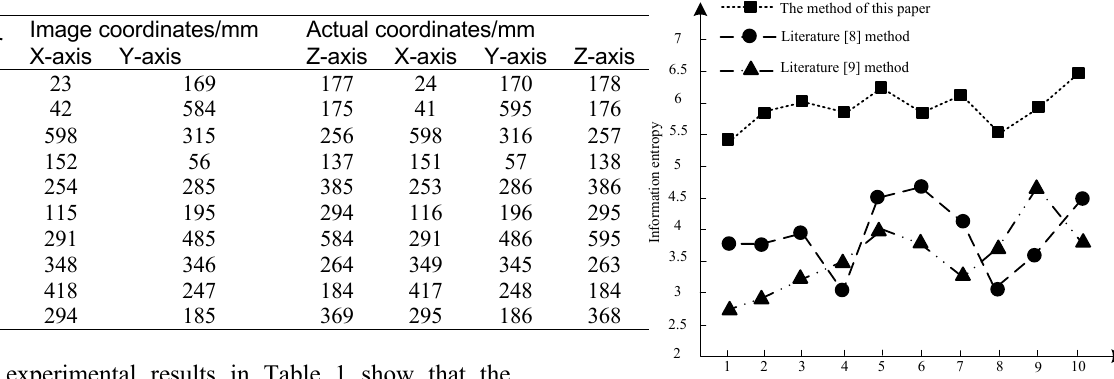
Figure 3. Information entropy